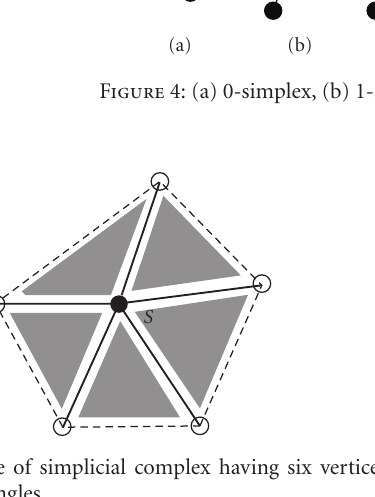
Figure 6: (a) A Voronoi cell and (b) the Voronoi diagram of a number of sites.